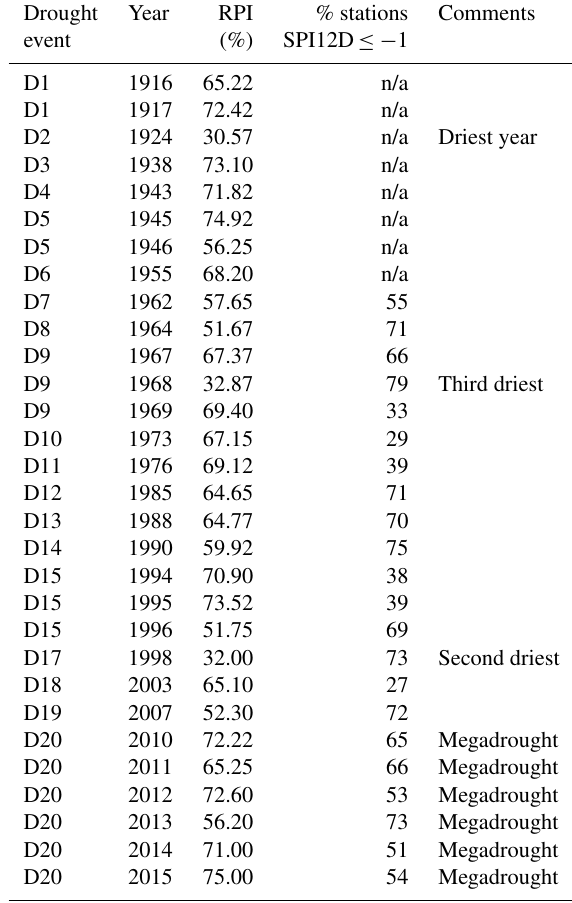
Table 2. Drought events in central